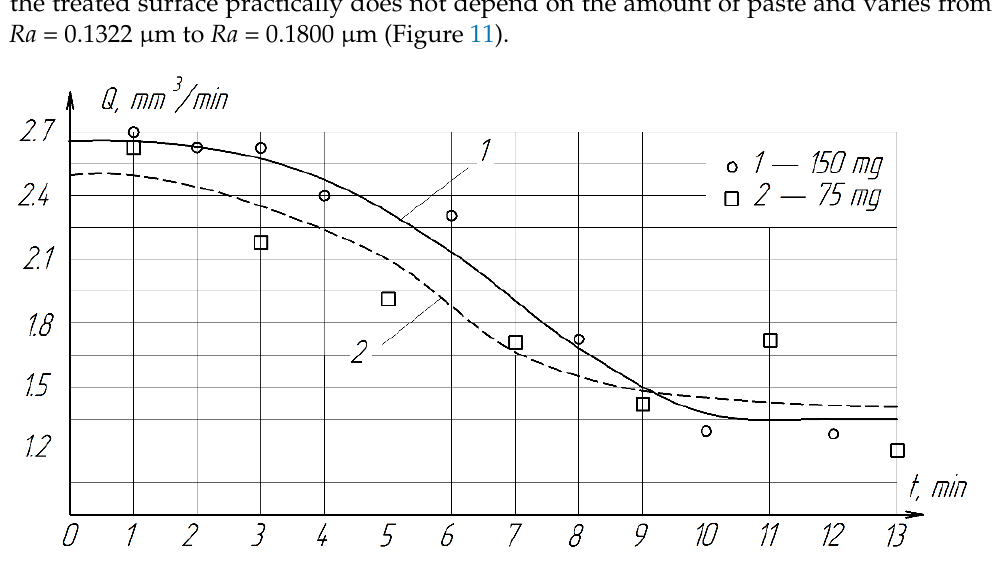
Figure 10. The effect of the amount of diamond paste on the processing performance of ZrO 2 ceramics.